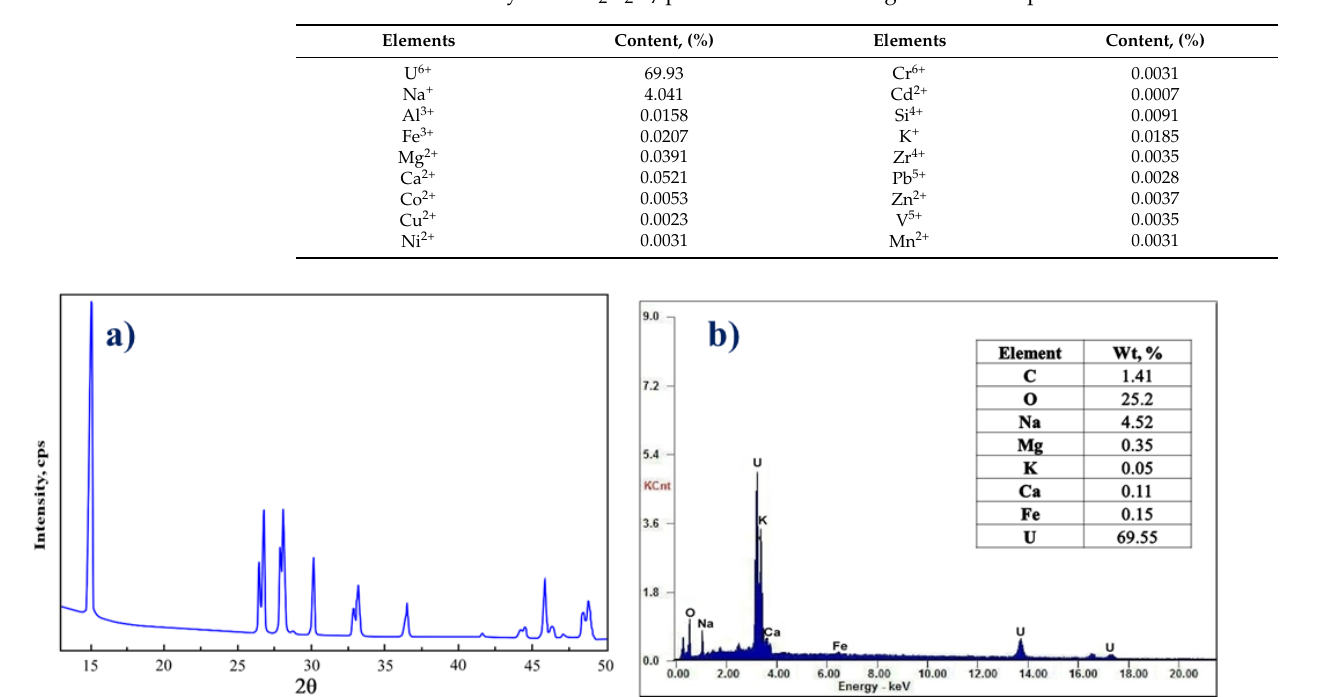
Table 8. ICP-OES analysis of Na 2 U 2 O 7 product from G. Gattar granite ore sample.